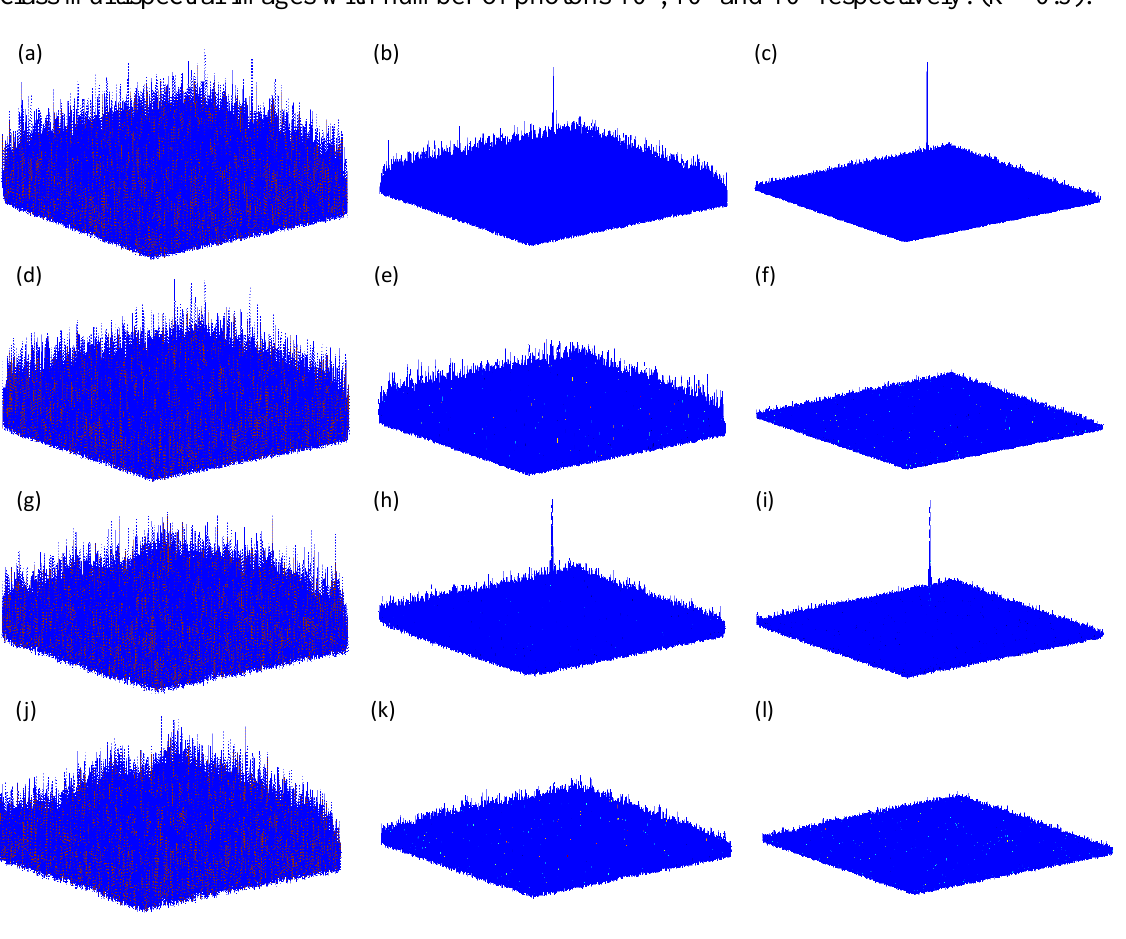
Figure 11. ( a – c ) Nonlinear correlation planes between reference and decrypted true class Bayer images with number of photons 10 3 , 10 4 and 10 5 respectively; ( d – f ) Nonlinear correlation planes between reference and decrypted false class Bayer images with number of photons 10 3 , 10 4 and 10 5 respectively; ( g – i ) Nonlinear correlation planes between reference and decrypted true class multispectral images with number of photons 10 4 , 10 5 and 10 6 respectively; ( j – l ) Nonlinear correlation planes between reference and decrypted false class multispectral images with number of photons 10 4 , 10 5 and 10 6 respectively. (k =